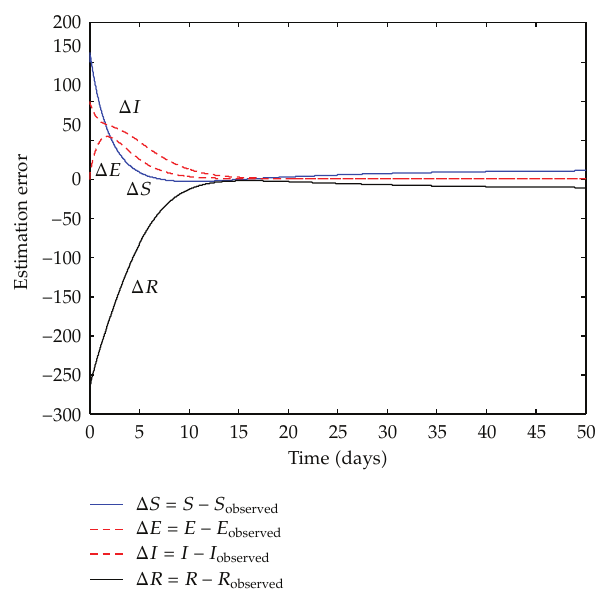
Figure 6: Observation error with vaccination and unknown parameters.